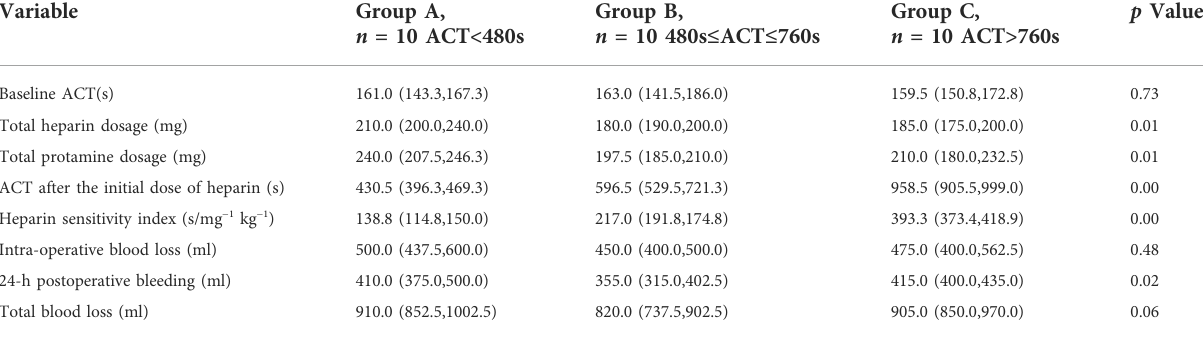
TABLE 4 Heparin sensitivity and